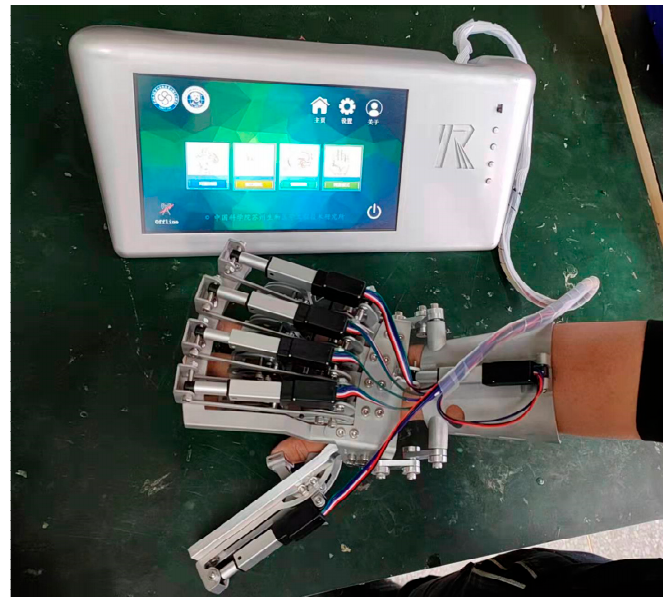
Figure 14. Prototype of hand rehabilitation robot before topology optimization.